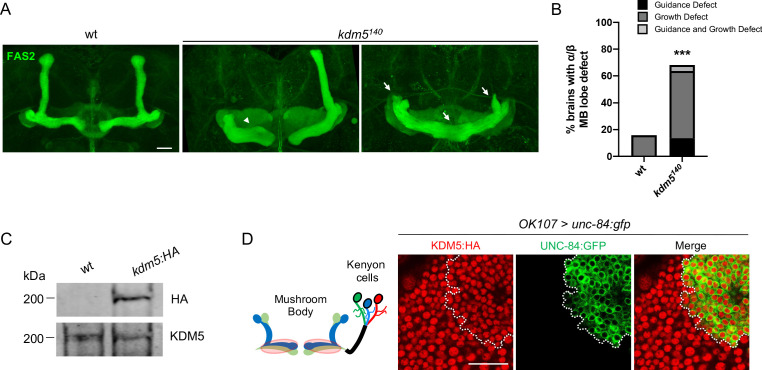
kdm5140 pharate adults have neuromorphological defects of the mushroom body (MB).(A) Representative α/β lobe Z projections of pharate wild-type (NP4707rev2 revertant) and kdm5140 strains. Arrows indicate growth defects, and arrowheads indicate guidance defects. The α/β lobes are revealed with anti-fasciclin 2. (B) Quantification of α/β lobe defects in wild-type and kdm5140 strains. n = 19–22 (mean n = 21). ***p<0.001 (chi-square test with Yates’ correction). (C) Western blot of w1118 and kdm5:HA adult heads confirming wild-type expression levels of lysine demethylase 5 (KDM5):HA within our endogenously tagged kdm5:HA strain. Anti-HA (top) and anti-KDM5 (bottom) loading control. (D) Schematic of an adult MB with its associated Kenyon cells (left). OK107-Gal4 is used to drive expression of UNC-84:GFP, an inner nuclear membrane GFP reporter, within MB neuroblasts, mushroom body-ganglion mother cells, and Kenyon cells (right). Brains are counterstained with anti-HA to demonstrate the presence of endogenously tagged KDM5:HA within Kenyon cell nuclei. Scale bars represent 20 μm.